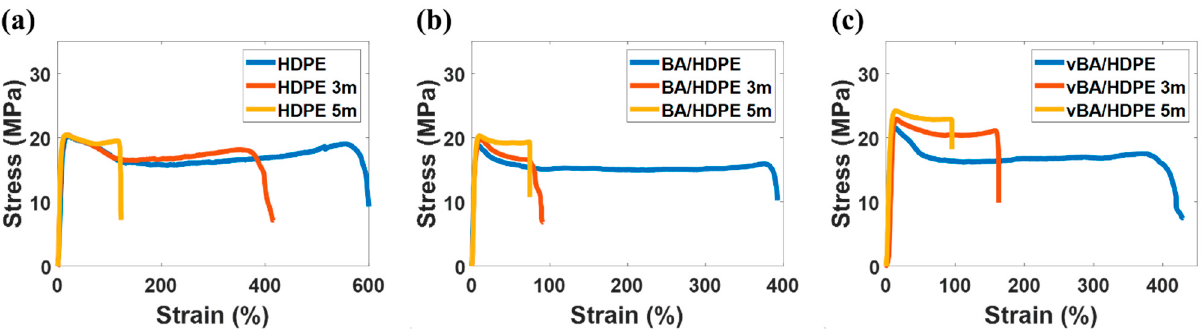
Figure 6. Stress–strain curves of pristine and irradiated HDPE ( a ), BA/HDPE ( b ), and vBA/HDPE ( c ).